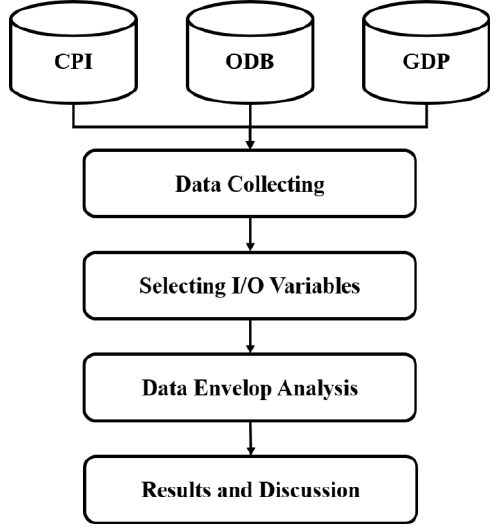
Figure 2. Study process diagram.